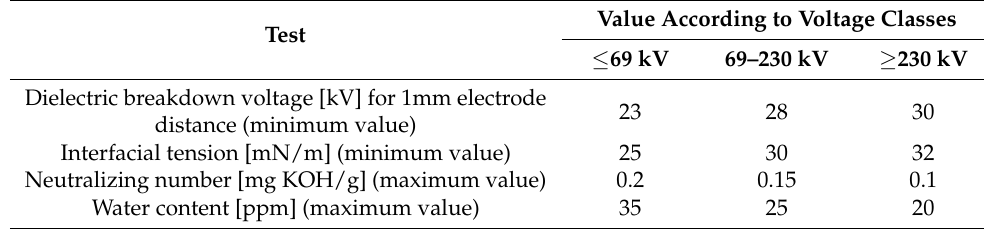
Table 10. Transformer oil quality tests and their limits.